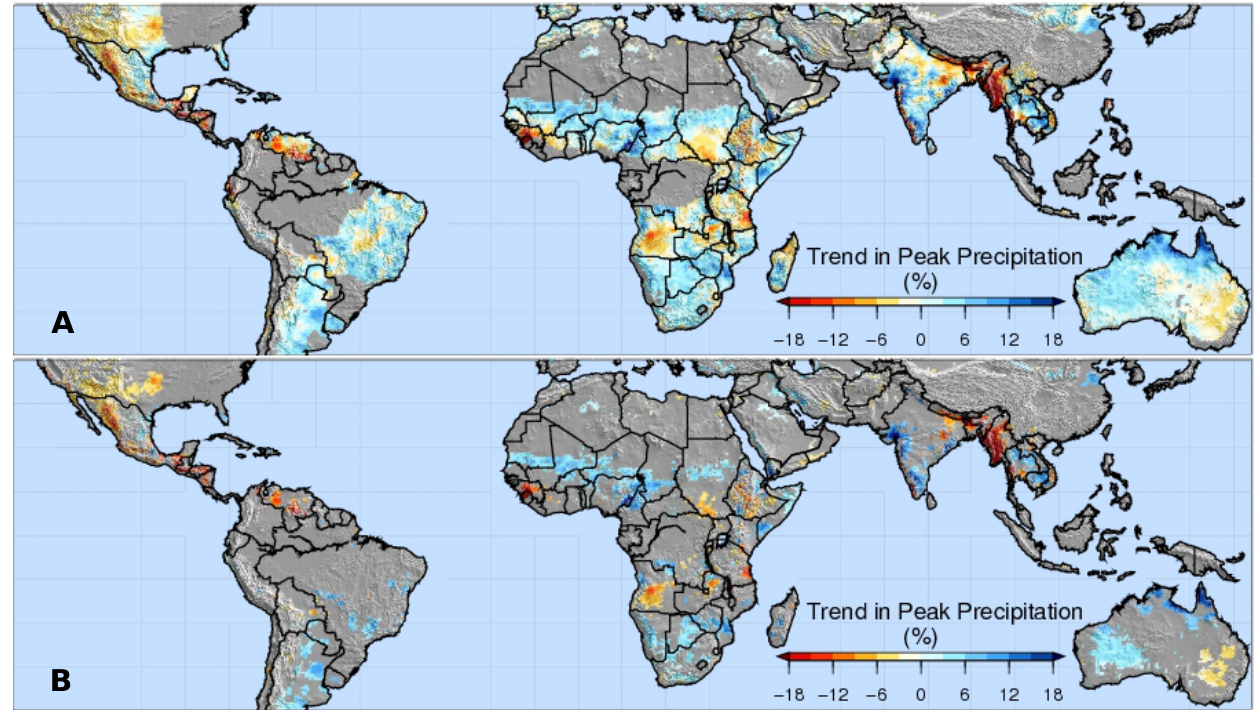
Figure 4. Trend in wet season precipitation (peak precipitation, %) for the period 1982 to 2006 for (A) all pixels of the WLT and for (B) statistically significant pixels only ( p <